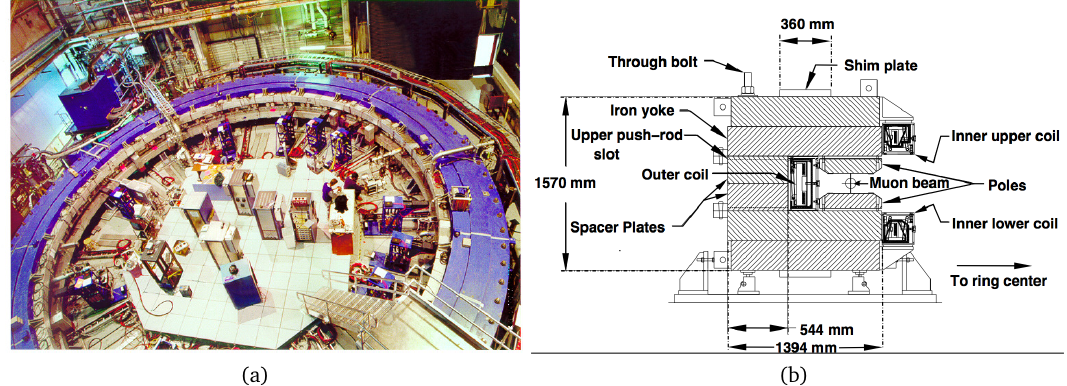
Figure 9: (a) A photograph of the E821 muon storage ring in the experimental hall at Brookhaven Laboratory. (Photograph by R. Bowman, courtesy of Brookhaven Na- tional Laboratory) (b) An elevation drawing of the storage ring cross section. (From Ref. [ 50 ] ).